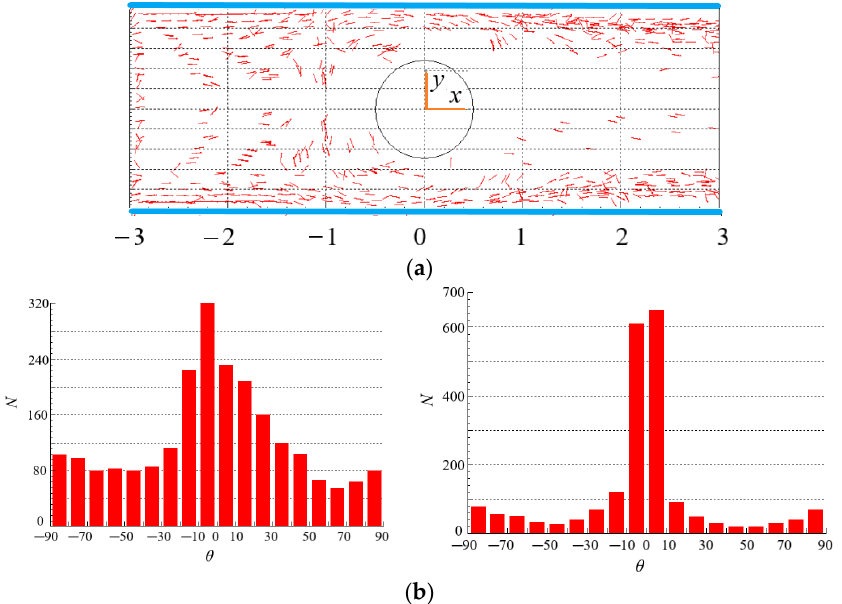
Figure 10. Spatial and orientation distributions of particles at n = 0.7 (Re = 200, β = 8). ( a ) spatial distribution. ( b ) orientation distribution: left: contraction flow ( x < 0); right: expansion flow ( x > 0).